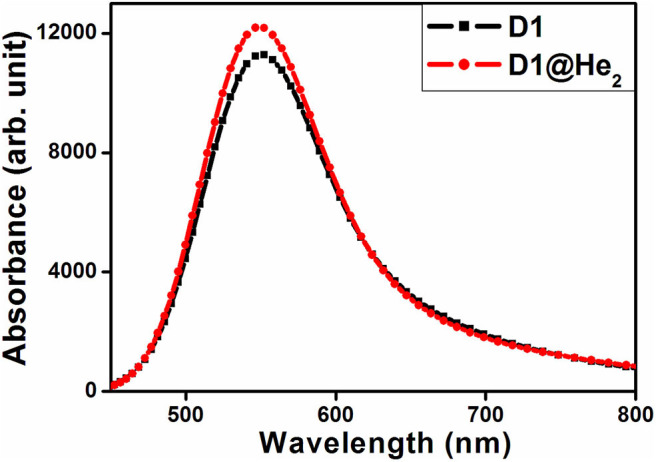
UV-visible absorption spectra of dyes D1 and D1@He2.